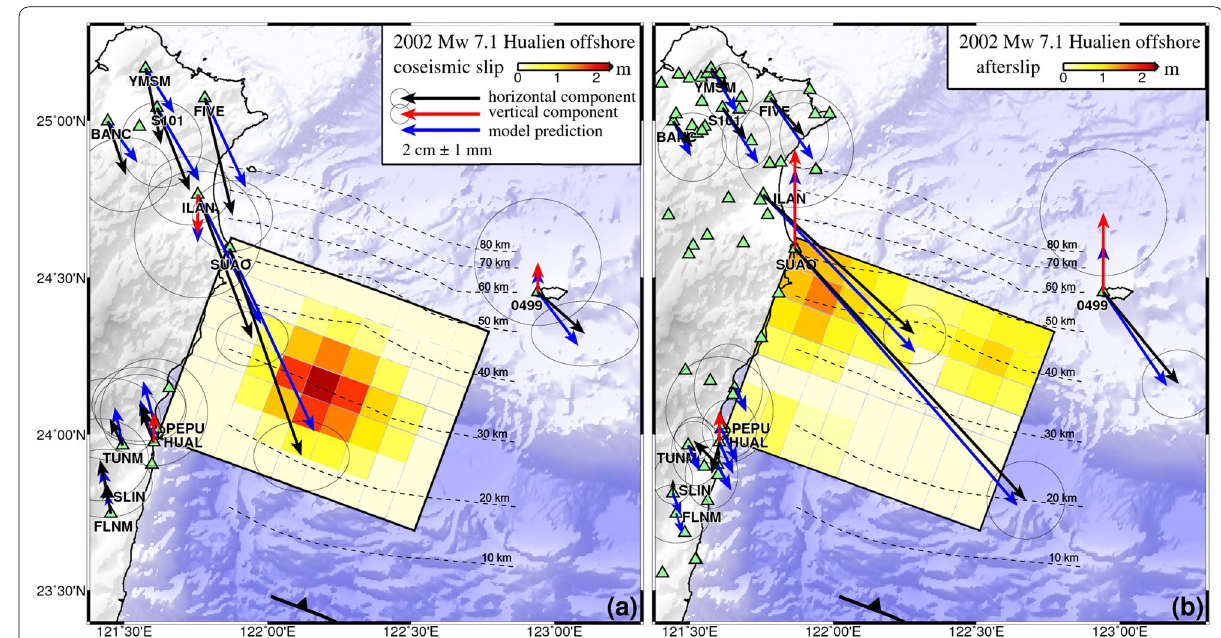
Fig. 3 Coseismic slip and afterslip distribution of the 2002 M w 7.1 Hualien offshore earthquake on an interface fault. Horizontal and vertical components of the surface displacements are shown by black and red arrows, respectively, on each GNSS station with the uncertainties in the ellipse sizes. The blue arrows represent surface displacements derived from dislocation